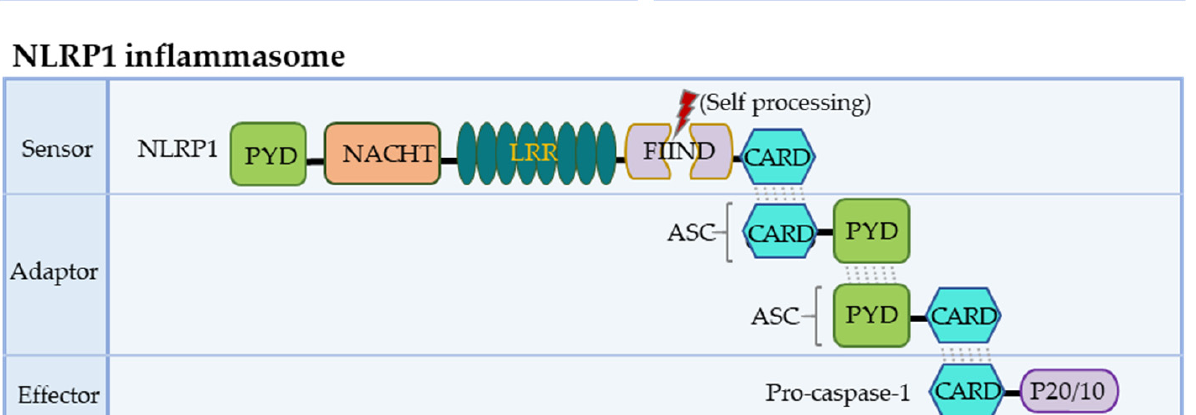
Figure 2. Assembly of canonical inflammasomes. An organization summary for the assembly of canonical inflammasomes, comprising sensors, adaptors/ASC, and effectors/caspase-1.